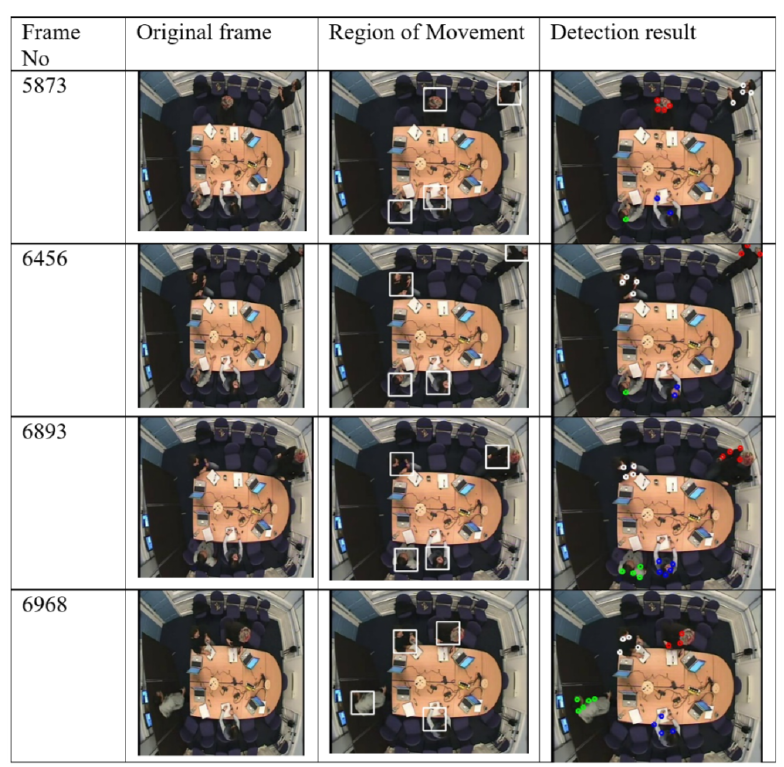
Figure 6. Detection results for different motions of people (i.e., low motion when people are sitting and significant motion when they are moving in a meeting